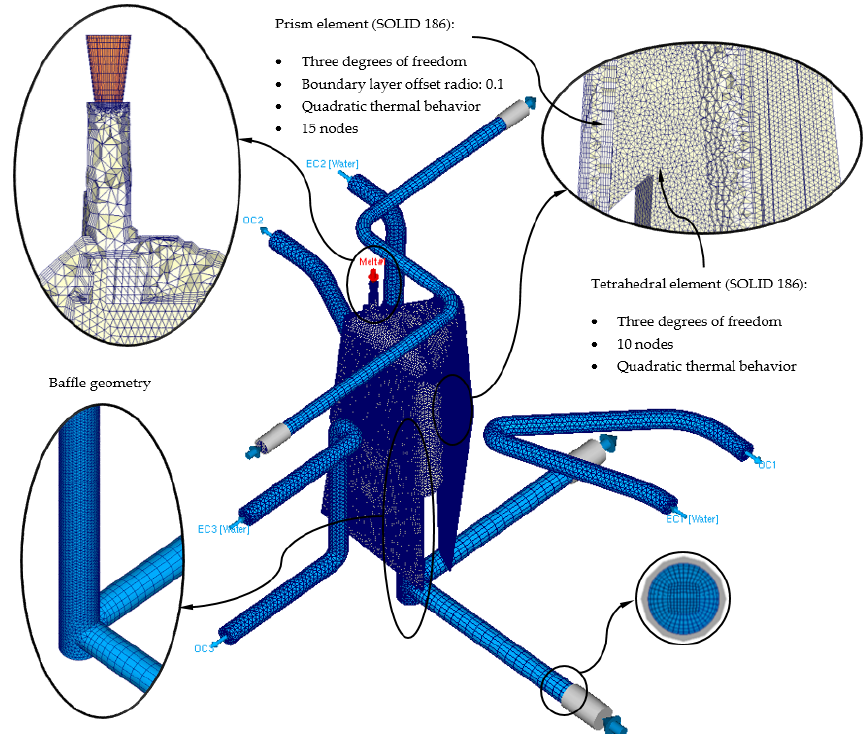
Figure 10. Mesh details for the traditional cooling configuration.